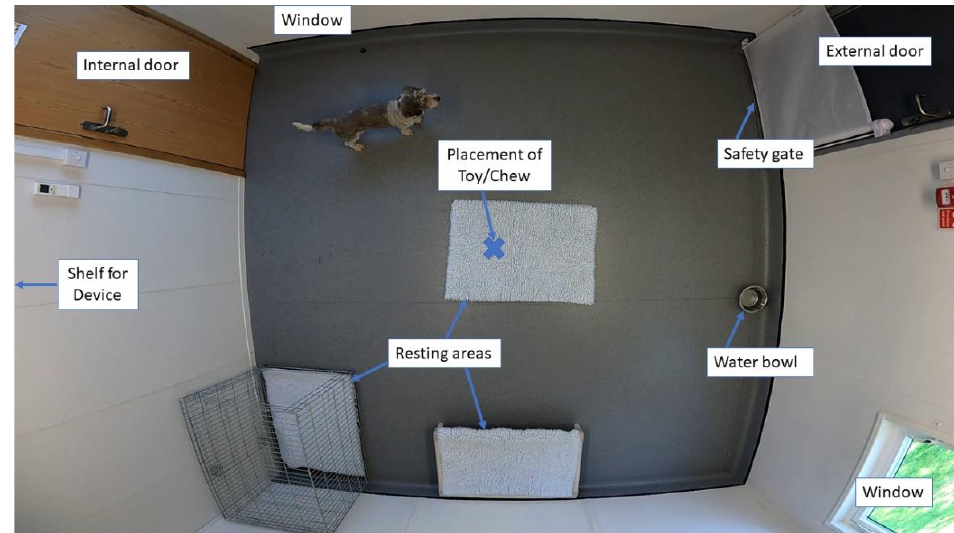
Figure 1. Test room setup used for social isolation events.